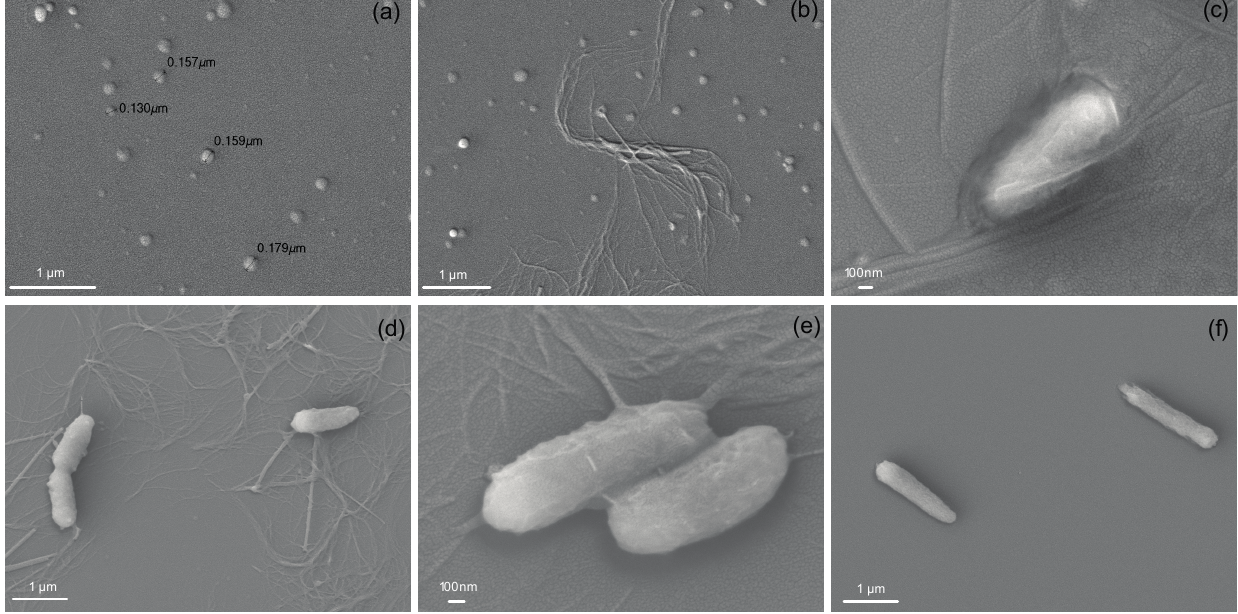
Figure 4. ( a ) SEM image of NPs; ( b ) SEM image of NPs and P. aeruginosa MDR cells at 4.4 × 10 3 cells/mL; ( c ) SEM image of NPs and P. aeruginosa MDR cells at 8.9 × 10 5 cells/mL; ( d , e ) SEM images of PDDA (1.0 mg/mL) and P. aeruginosa MDR cells at 8.9 × 10 5 cells/mL; ( f ) P. aeruginosa MDR cells. Final concentrations in the NPs are 0.05 mM DODAB, 0.05 mg/mL CMC and 0.05 mg/mL